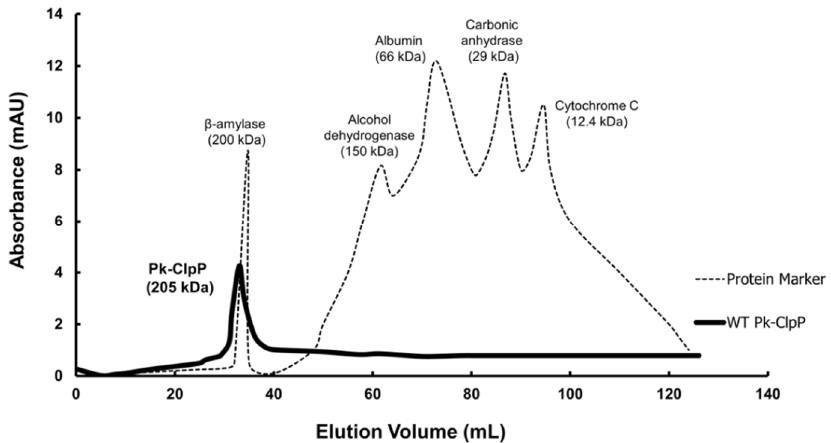
Figure 5. Elution profile of ClpP from Plasmodium knowlesi (Pk-ClpP) under size-exclusion chroma- tography (SEC). The elution profile of protein markers (β-amylase, alcohol dehydrogenase, albu- min, carbonic anhydrase, and cytochrome C) are shown for comparison.